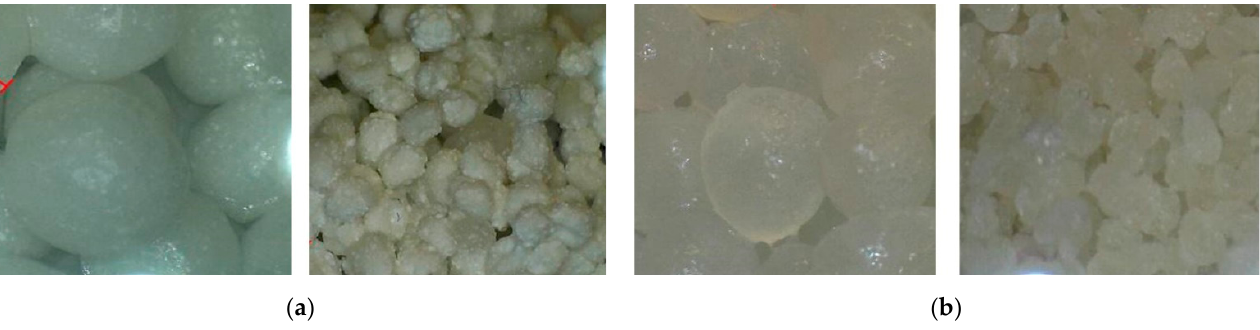
Figure 3. Photograph with a digital microscope: ( a ) wet and dry Al@12-O-12 +BaSO 4 ; ( b ) wet and dry Al@12-O-12.